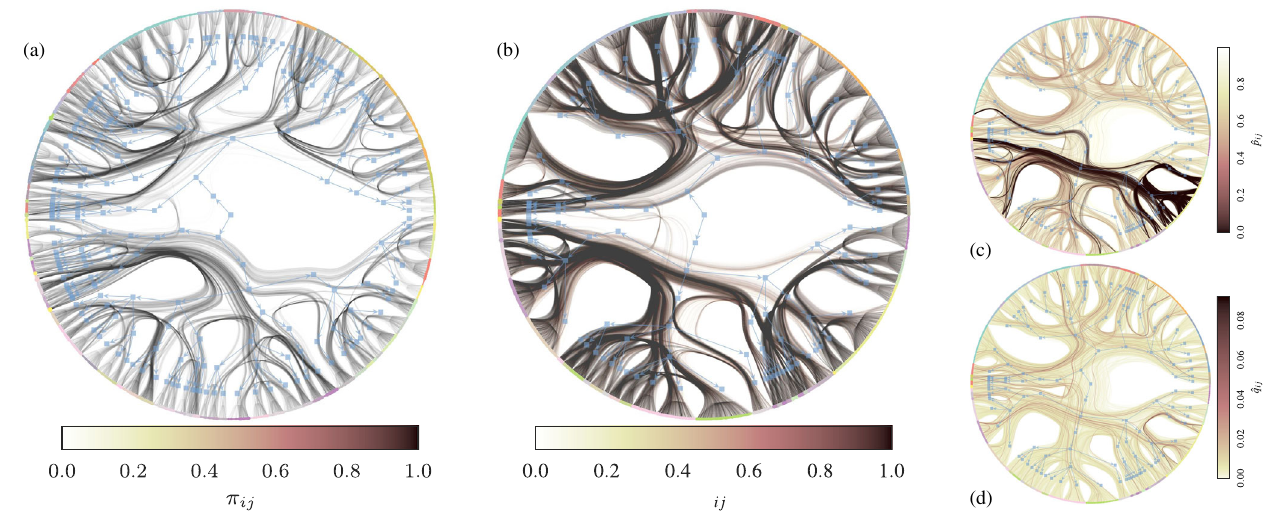
FIG. 14. Reconstruction results for the human connectome. (a) Marginal posterior distribution of edges π ij and inferred hierarchical partition, according to the model with uniform errors. The upper hierarchy branch corresponds to the right hemisphere. (b) The same as (a) but with the nonuniform model. (c) Inferred missing edge probabilities p ij for the nonuniform model. (d) The same as (c) but for the spurious edge probabilities q ij .